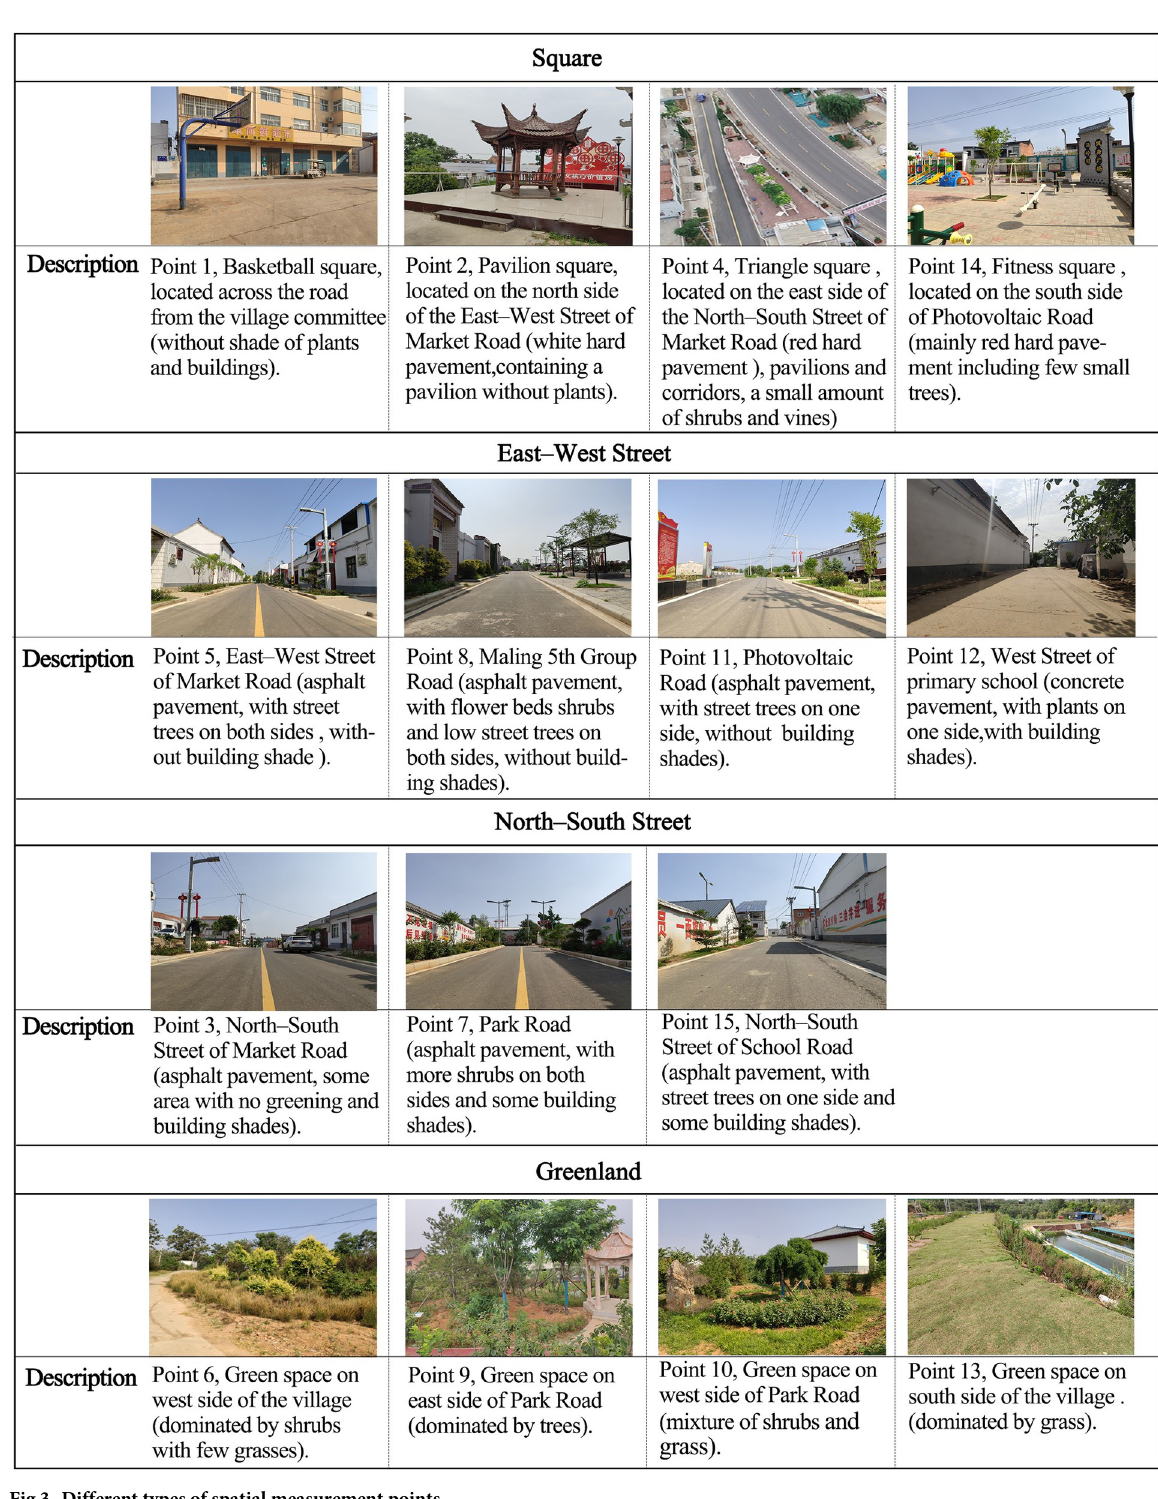
Fig 3. Different types of spatial measurement